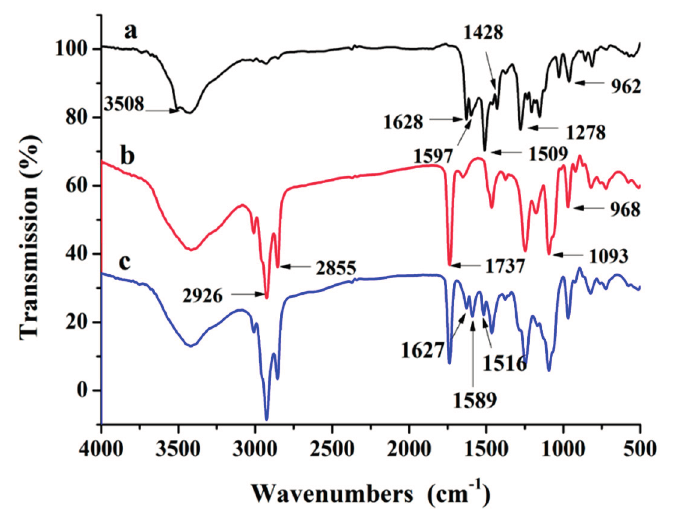
Figure 3. FT-IR spectrum of curcumin powder ( a ); phospholipid ( b ); and curcumin nanoliposome ( c